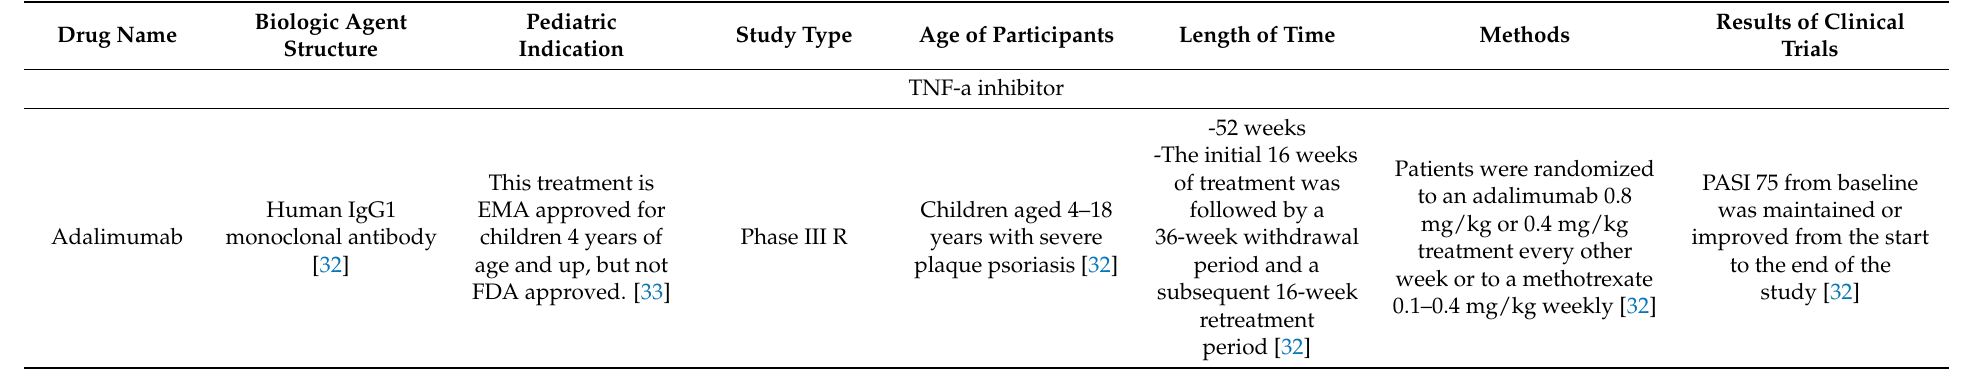
Table 2. Biologics indicated for the treatment of psoriasis in